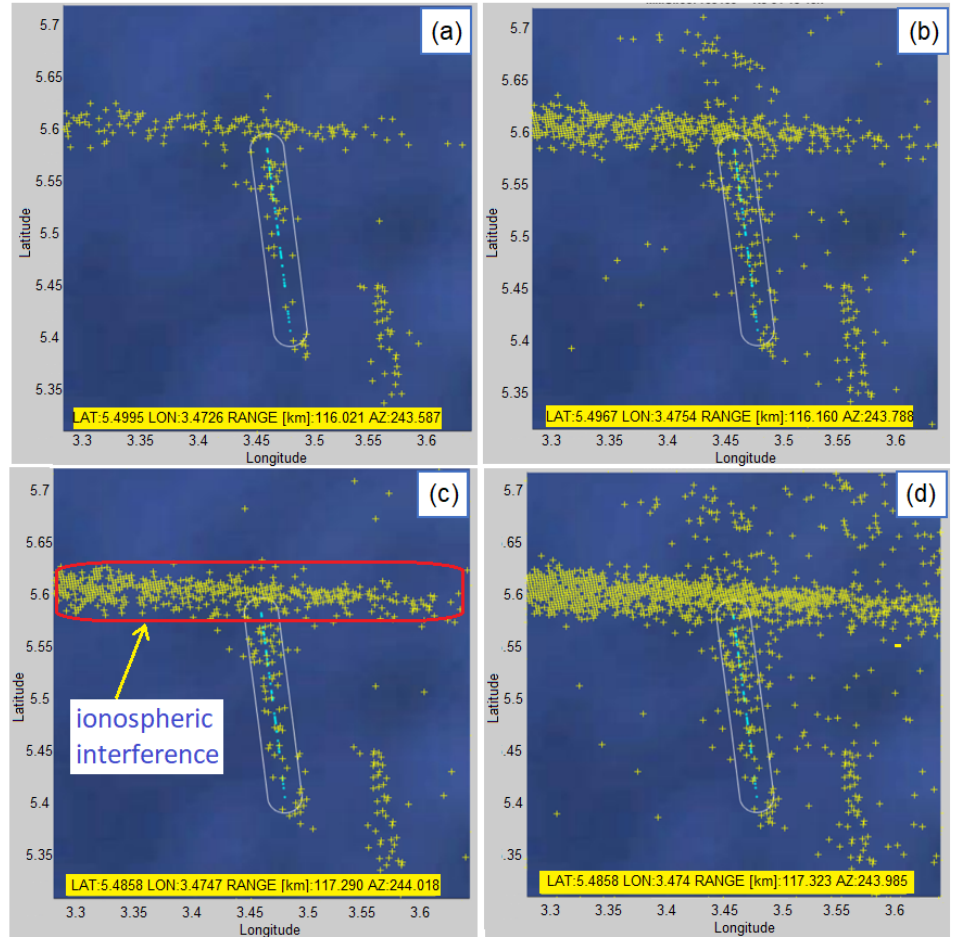
Figure 22. The display of all detections of vessel with MMSI = 657199400 (yellow markers) with AIS data as a benchmark (light blue tracks) in a time interval of 1 h (18–19 h) for different detection parameters of the proposed algorithm: ( a ) K = 5 and normalized threshold = 0.2 ( b ) K = 5 and normalized threshold = 0.1 ( c ) K = 10 and normalized threshold = 0.2 ( d ) K = 10 and normalized threshold =